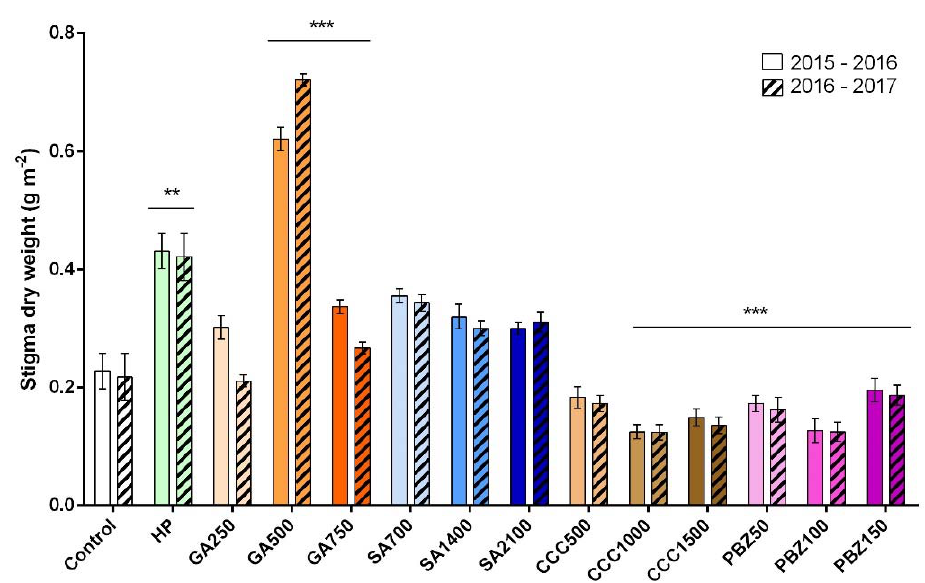
Figure 5. Effects of corm priming with distilled water and four different growth regulators on stigma dry weight of saffron plants grown under field condition. HP, hydropriming; GA, gibberellic acid; SA, salicylic acid; CCC, chlormequat chloride; PBZ, paclobutrazol. Data are shown as mean ± standard deviation; *** p < 0.001 vs. control group; ** p < 0.005 vs. control group. The empty white and colored columns correspond to the data for the years 2015–2016. The white and colored columns with oblique lines correspond to the years 2016–2017.